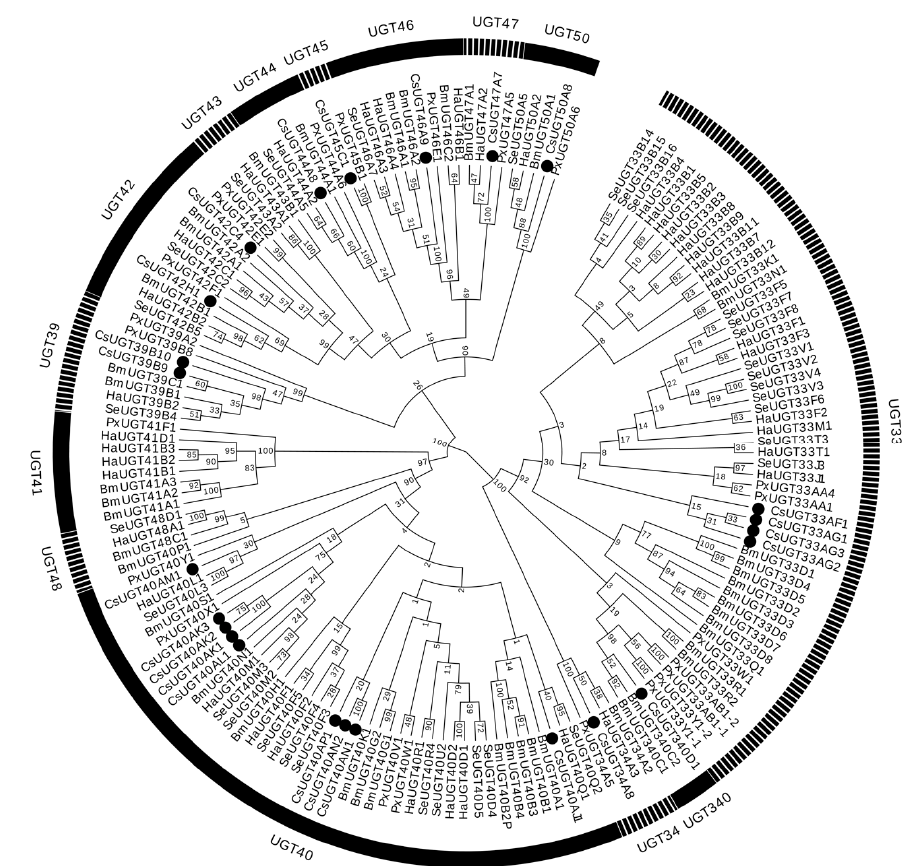
Figure 1. Phylogenetic relationship of UGTs from different species using the complete amino acid sequences. Twenty-four UGT amino acid sequences from Chilo suppressalis (Cs before the name), 23 from Plutella xylostella (Px), 32 from Spodoptera exigua (Se), 40 from Helicoverpa armigera (Ha), and 44 from Bombyx mori (Bm). The tree was constructed with MEGA 5.0, using the neighbor-joining method with the Poisson correction model and 1000 bootstrap replicates. The identified UGTs are highlighted with solid black